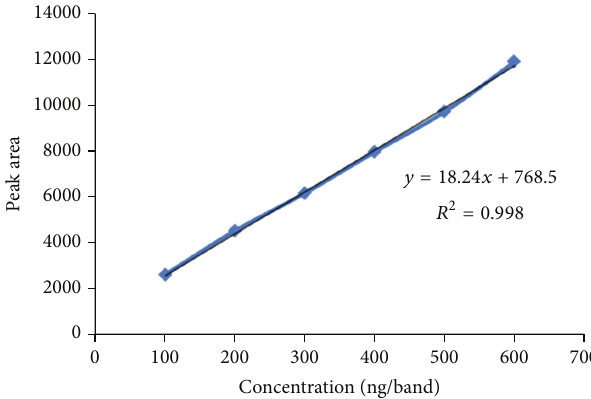
Figure 3: Calibration curve of thiocolchicoside (100–600ng per band).